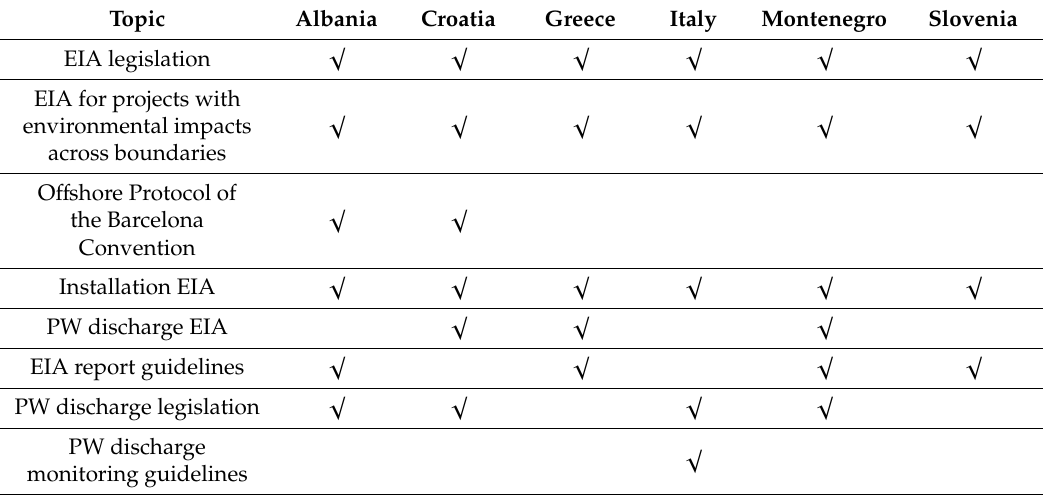
Table 1 resumes the comparison of the main EIA topics in the ADRION region. Table 1. Environmental impact assessment: main topics considered at ADRION